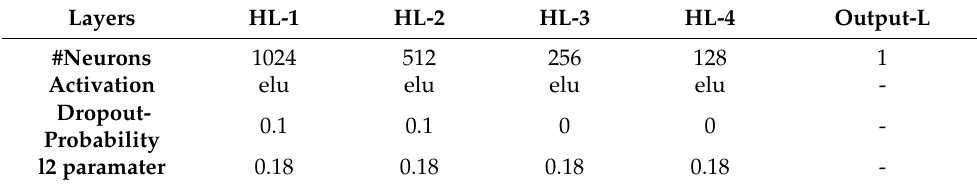
Table 7. Final deep neural network architecture.